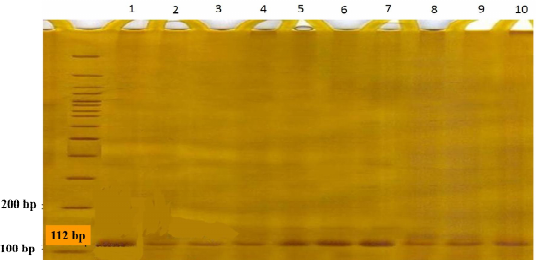
Fig. 1. Pattern of amplification of exon 2 of BMP15 gene in polyacrylamide gel electrophoresis (before digestion) of different samples (columns 1-10)